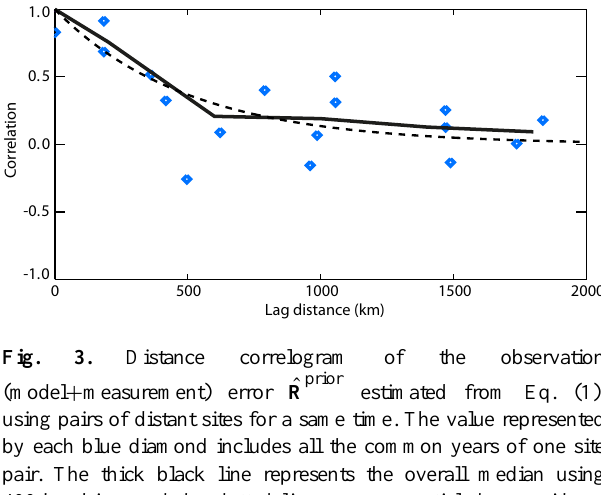
Fig. 3. Distance correlogram of the observation prior (model + measurement) error ˆ R estimated from Eq. (1), using pairs of distant sites for a same time. The value represented by each blue diamond includes all the common years of one site pair. The thick black line represents the overall median using 400-km bins, and the dotted line an exponential decay with an e-folding length of